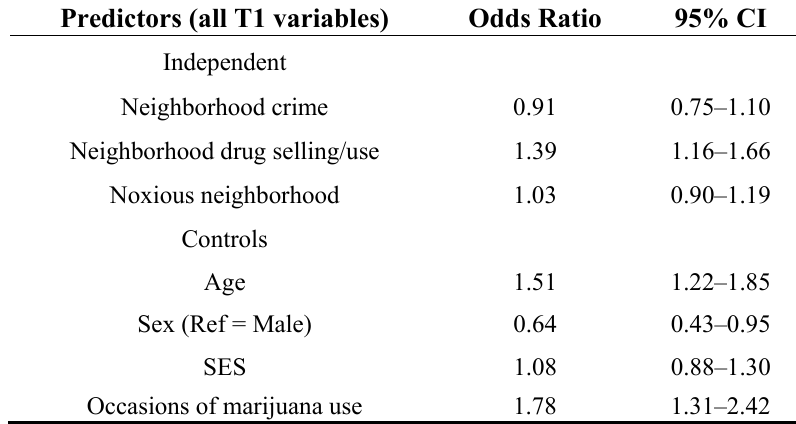
Table 3. Prospective association of neighborhood characteristics and occasions of marijuana use: Results of ordinal logistic regression ( N =